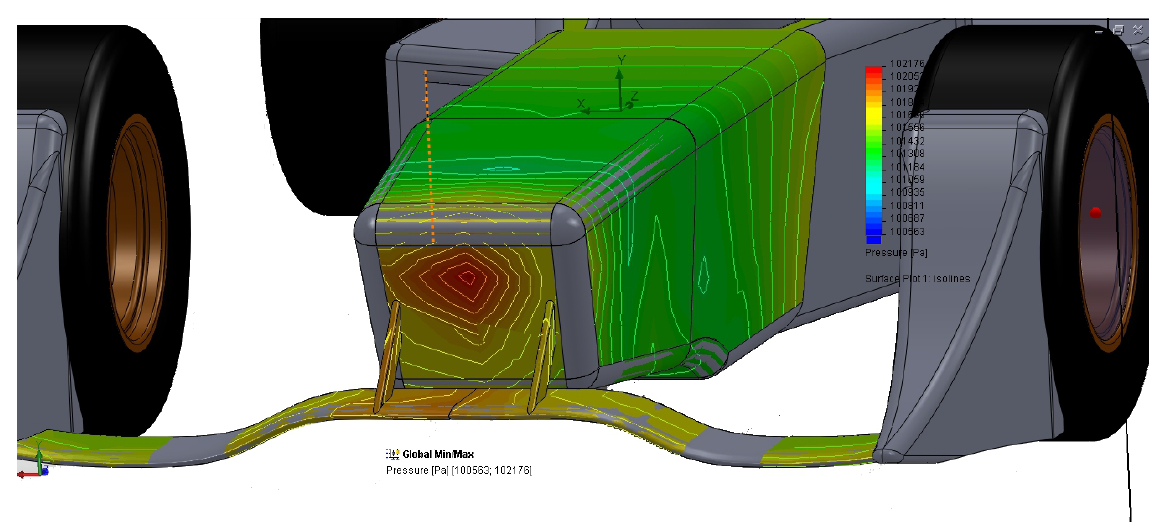
Figure 11. Air flow pressure distribution on optimized prototype nose body (front